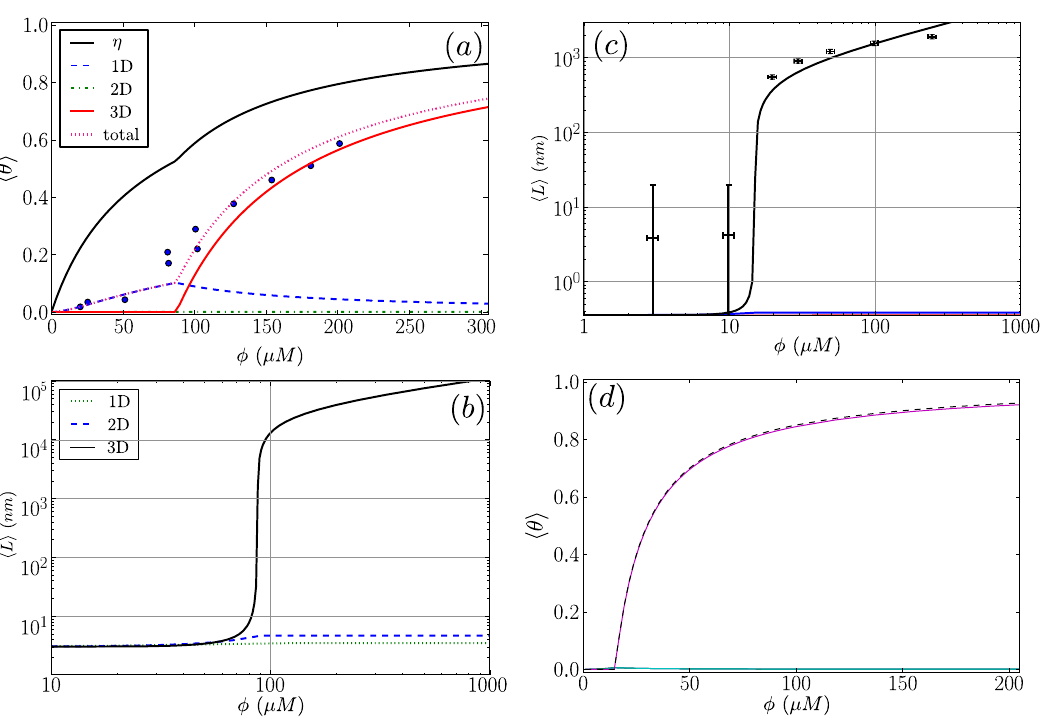
(cid:105) for 1D, 2D, and 3D structures in the A β (1-40) model. Black dots Figure 9. ( a ) Plot of (cid:104) θ 2 represent the CD data from Terzi, et al. [52], where we the total fraction of sheet proteins in aggregates of any species; ( b ) Predicted average lengths, (cid:104) L (cid:105) , of the A β (1-40) fibrils using the fit parameters found in ( a ); In plot ( c ), the AFM data for the α -synuclein fibrils is plotted = 4 strip lattice as black dots, along with the fit function (cid:104) L (cid:105) [68]. We fit (cid:104) L (cid:105) using the L y (cid:105) for α -synuclein (solid, purple curve) is compared with ρ /φ (dashed, model; In ( d ), (cid:104) θ 2 fib black curve) by using the fit parameters found in ( c ); In ( a ) and ( b ), the fit parameters for = 7 . 41 RT , B = 1 . 4 RT , R = − 2 . 47 RT , and K = 0 . 45 RT . the A β (1-40) model were: P 1 2 In ( a ), η = 1 − ( z + z 2 + z 4 ) /φ ; In ( c ) and ( d ), the fit parameters for the α -synuclein model = K = 2 . 7 RT , B = 1 . 95 RT and R = − 1 . 64 RT were P 1 2